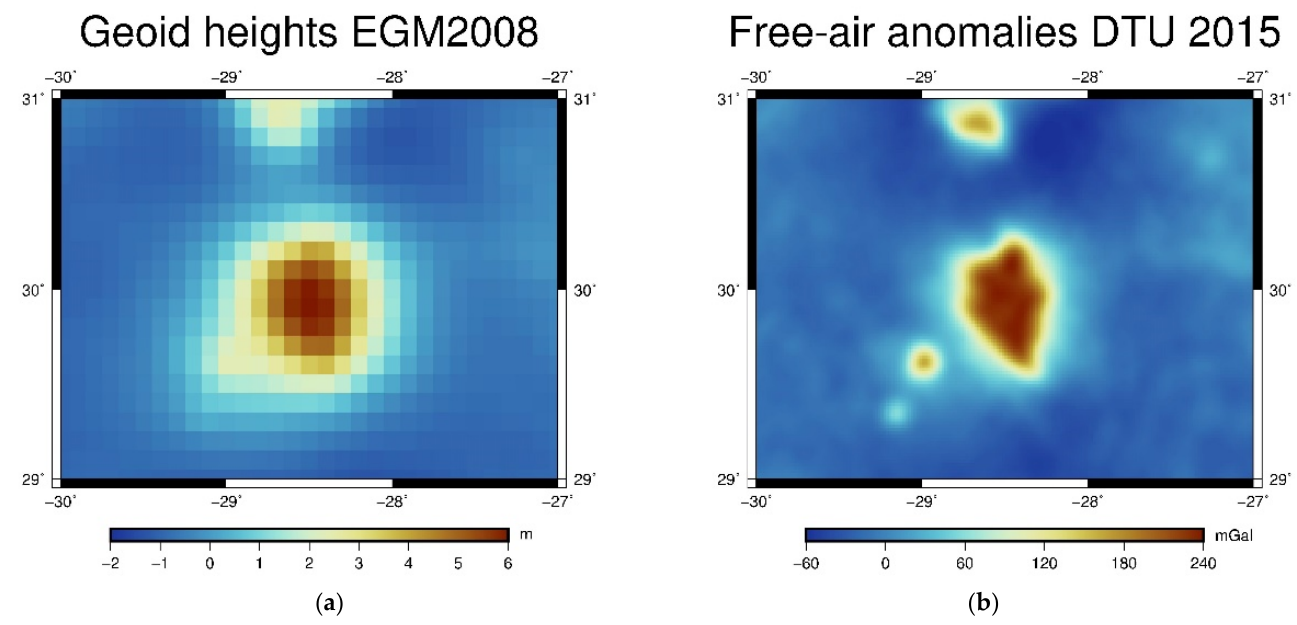
Figure 4. Gravimetric data ( a ) EGM2008 geoid heights; ( b ) DTU 2015 free-air anomalies.